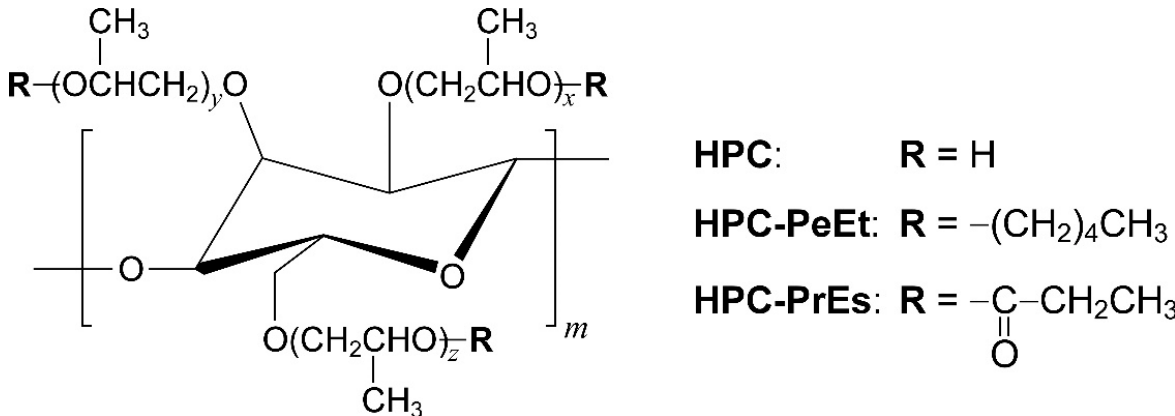
Figure 1. Chemical structures of pristine hydroxypropyl cellulose (HPC) and its etherified derivative possessing pentyl side-chains (HPC-PeEt). To compare the rheological results of HPC-PeEt in Figure 5, the previous results of an esterified HPC derivative possessing propionyl side-chains (HPC-PrEs) will be discussed in Section 3.4.